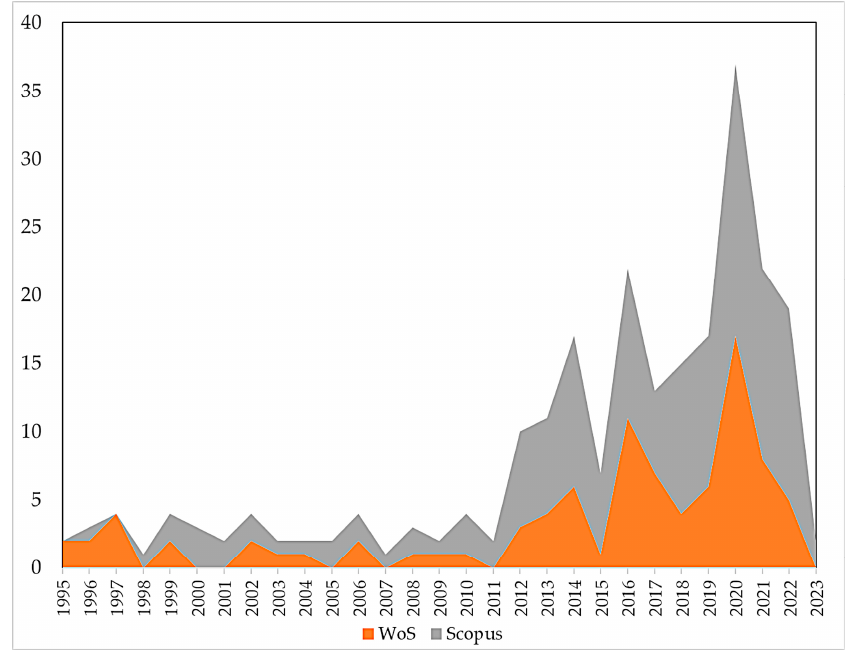
Figure 5. Number of articles published annually using first query. Source: Own elaboration.